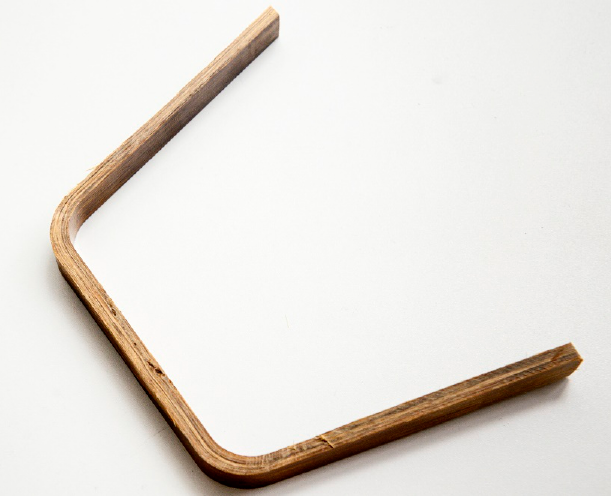
Figure 5. Transverse reinforcement (stirrup) made from bamboo composite material.